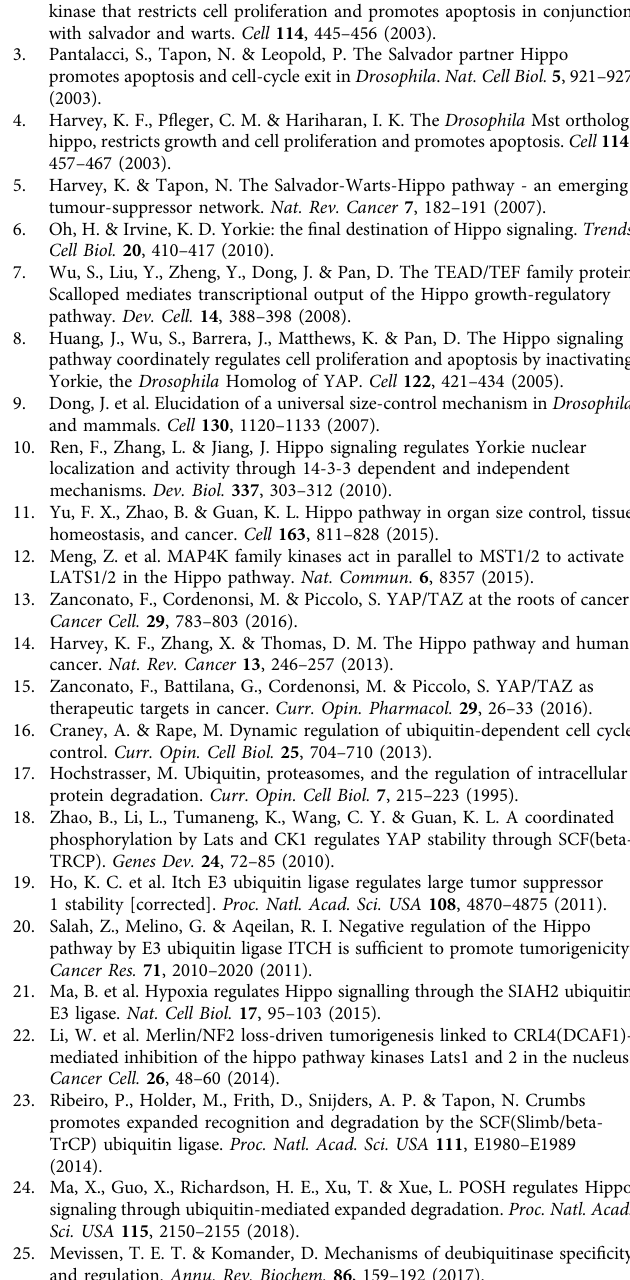
Fig. 7 Herpes virus-associated ubiquitin-speci fi c protease (HAUSP) and Yap are upregulated in hepatocellular carcinoma (HCC) samples. a , b The relative expression of HAUSP ( a ) and Yap ( b ) in 60 pairs of HCC and normal liver samples. Each bar was the log 2 value of the ratio of HAUSP or Yap protein levels between HCC (C) and matched normal tissues (N) from the same patient. The bar > 0 represented HAUSP was upregulated in HCC sample because log 2 1 = 0, vice versa. c Comparison between HAUSP elevation and Yap elevation in HCC samples. The overlapping region represented both HAUSP and Yap elevation cases. d Relative mRNA levels of indicated genes from HCC samples and matched normal tissues were revealed by real-time PCR. e Relative mRNA levels of indicated genes from Huh7 cells were revealed by real-time PCR. f Relative mRNA levels of indicated genes from Huh7 cells were revealed by real-time PCR. g MTT results of Huh7 cells transfected with indicated constructs or siRNAs. h Immunoblots of lysates from Huh7 cells treated with Usp7 inhibitor P5091 at indicated concentrations for 24 h. Actin acts as a loading control. i Relative mRNA levels of indicated genes from Huh7 cells treated with P5091 at distinct concentrations for 24 h. j Cell proliferation of Huh7 cells treated with P5091 at indicated concentrations for 24 h. k Immunoblots of lysates from Huh7 cells treated with Usp7-IN-1 or HBX-19818 at indicated concentrations for 24 h. Actin acts as a loading control. l Usp7 inhibitors suppressed Yap ubiquitination. Quantative data are shown as means ± SEM. n = 3 biological-independent experiments. In all above results, ** P < 0.01, *** P